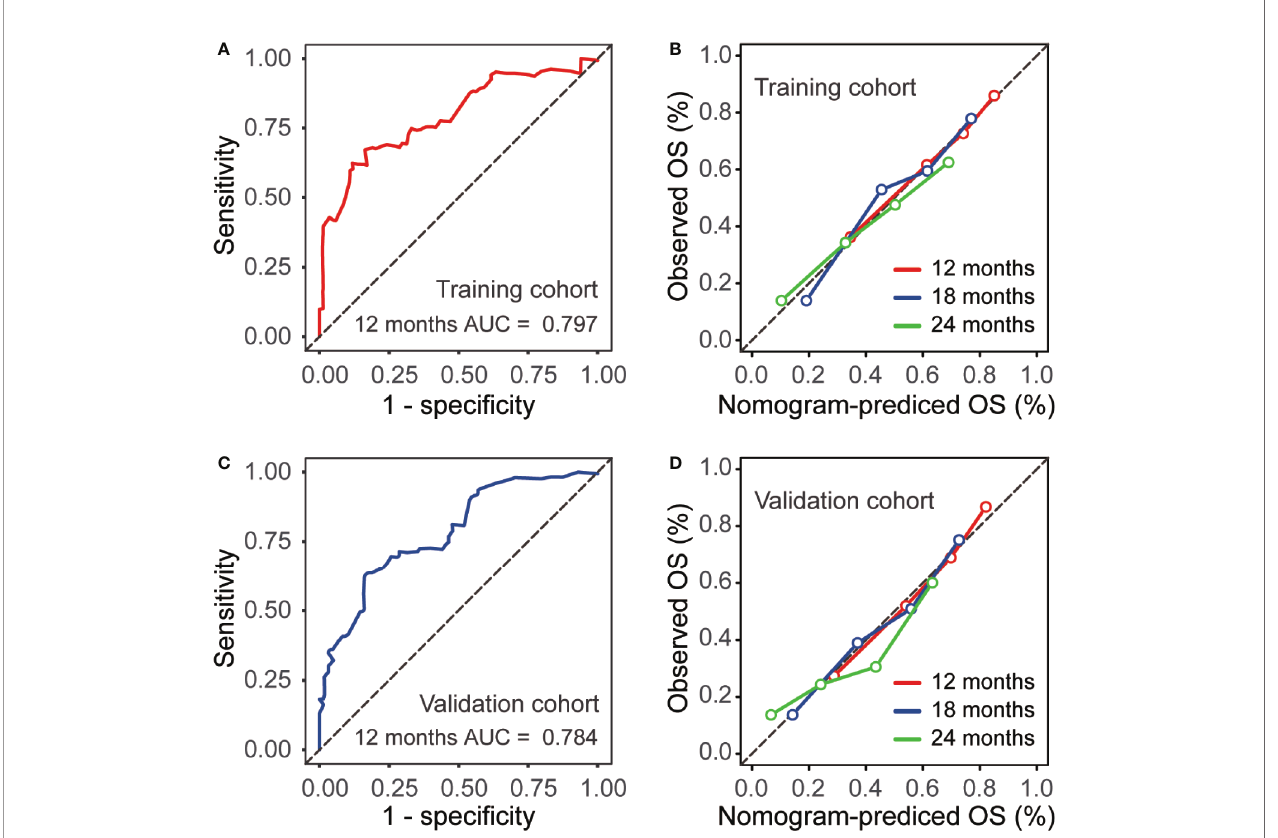
FIGURE 3 | Receiver operating characteristic (ROC) analysis and calibration curves for the training and validation cohort. (A) ROC curve for the prediction model in the training cohort. (B) Calibration plot comparing nomogram-predicted and observed overall survival in the training cohort. (C) ROC for the prediction model in the validation cohort. (D) Calibration plot comparing nomogram-predicted and observed overall survival in the validation